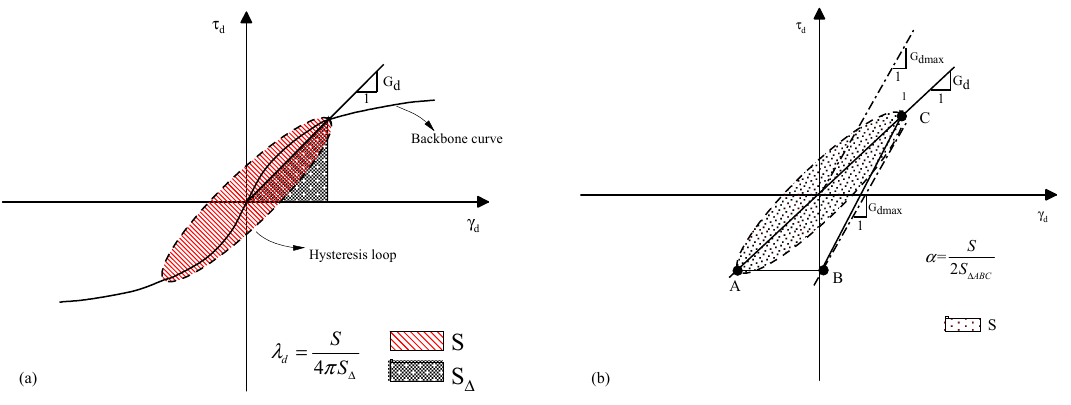
Figure 7. Geometric illustration of dynamic shear modulus and damping ratio. ( a ) Backbone curve and damping ratio calculation. ( b ) Dynamic shear modulus schematic.